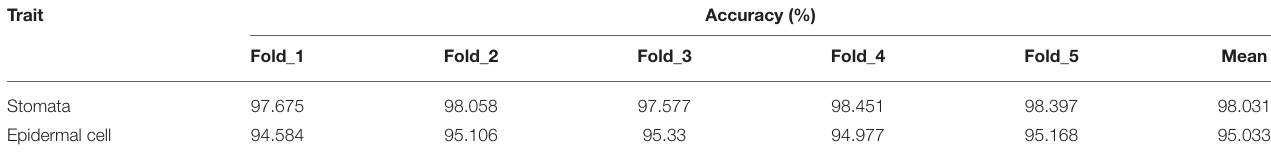
TABLE 1 | The counting accuracies of stomata and epidermal cells over 5-fold cross-validation.